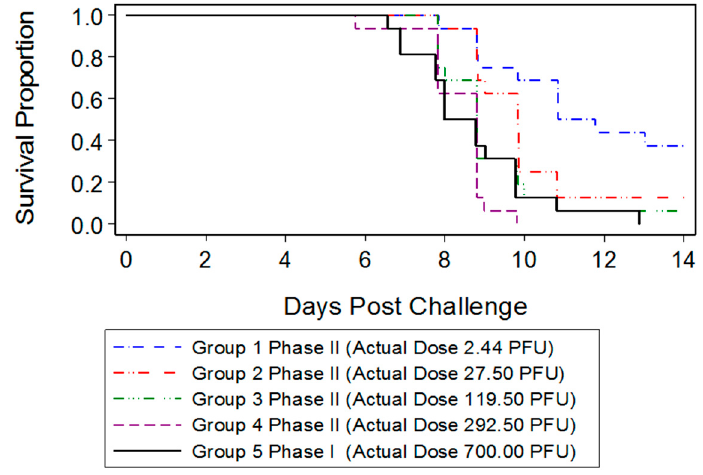
Figure 1. Lethal dose (LD) range survival data for determination of LD 50 and LD 90 . The mean time ‐ to